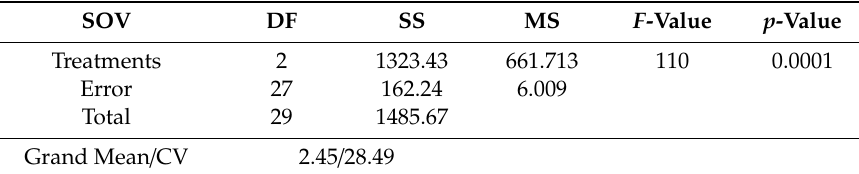
Table A2. Di ff erences of M. persicae number after 5 days in PeBL1-treated, bu ff er, and control cucumber seedlings.